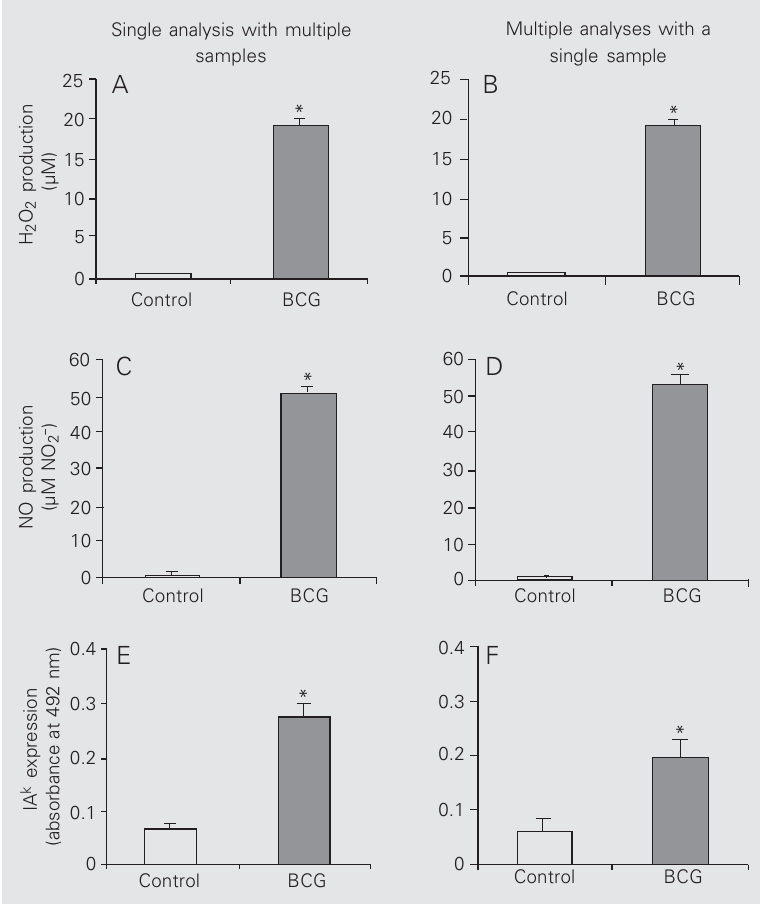
Figure 1. Comparison of H 2 O 2 release, NO production and MHC class II (IA k ) expression by bacillus Calmette-Guérin (BCG)-activated peritoneal macrophages. C3H/HePas mice were injected ip with 2 mg BCG or 0.2 ml PBS at days 0 and 14 and the macrophage functions determined 4 days later. H 2 O 2 release, NO production and MHC II expression were determined using multiple cell samples (left) or a single cell sample (right). H 2 O 2 release (A and B) was quantified 1 h after cell culture. NO production (C and D) was determined 48 h after cell culture. IA k expression was evaluated after 1 h using multiple cell samples (E) or 48 h after cell culture using a single cell sample (F). One representative experiment of three is shown. Results are reported as means ± SEM (N = 5). *P < 0.05 for BCG compared to control (ANOVA). There was no statistical difference between single and multiple analyses (ANOVA). MHC, major histocompatibility complex; NO, nitric